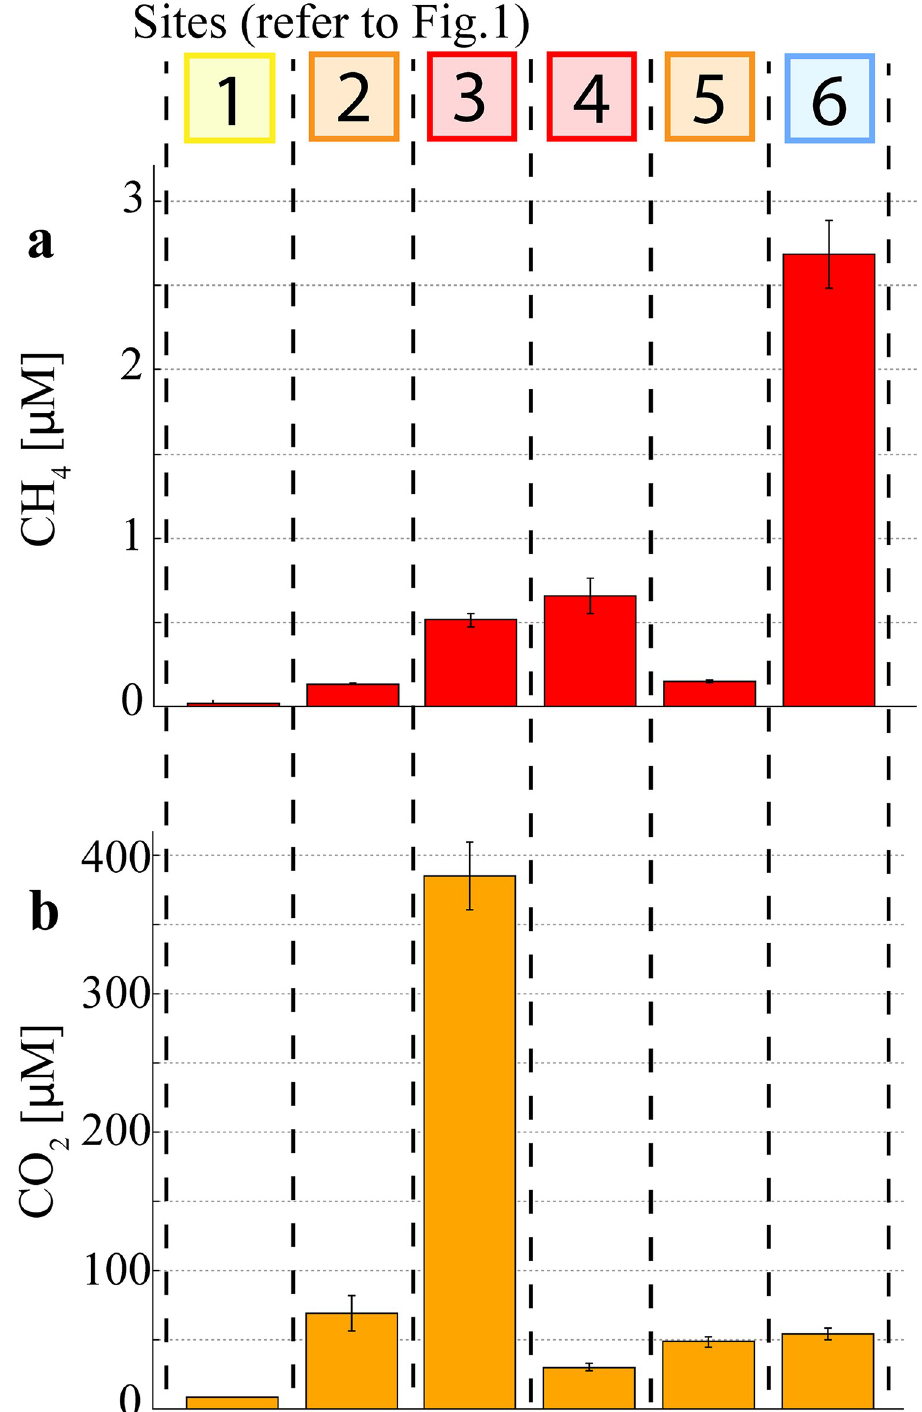
Fig 4. Water column greenhouse gas concentrations along the Burnett estuary land use gradient. Note: Error bars represent ± SD of averaged data from CRDS.